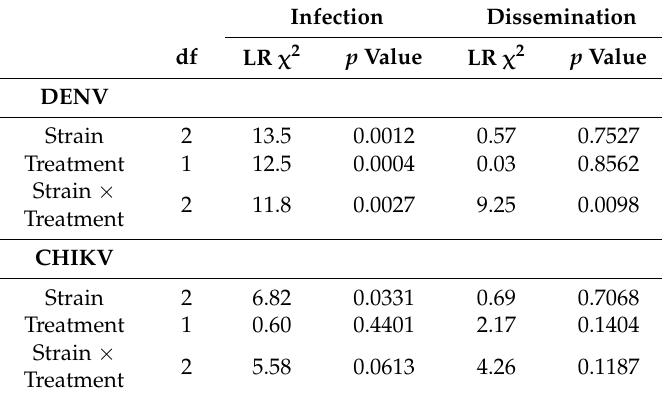
Table 1. Test statistics of arbovirus susceptibility